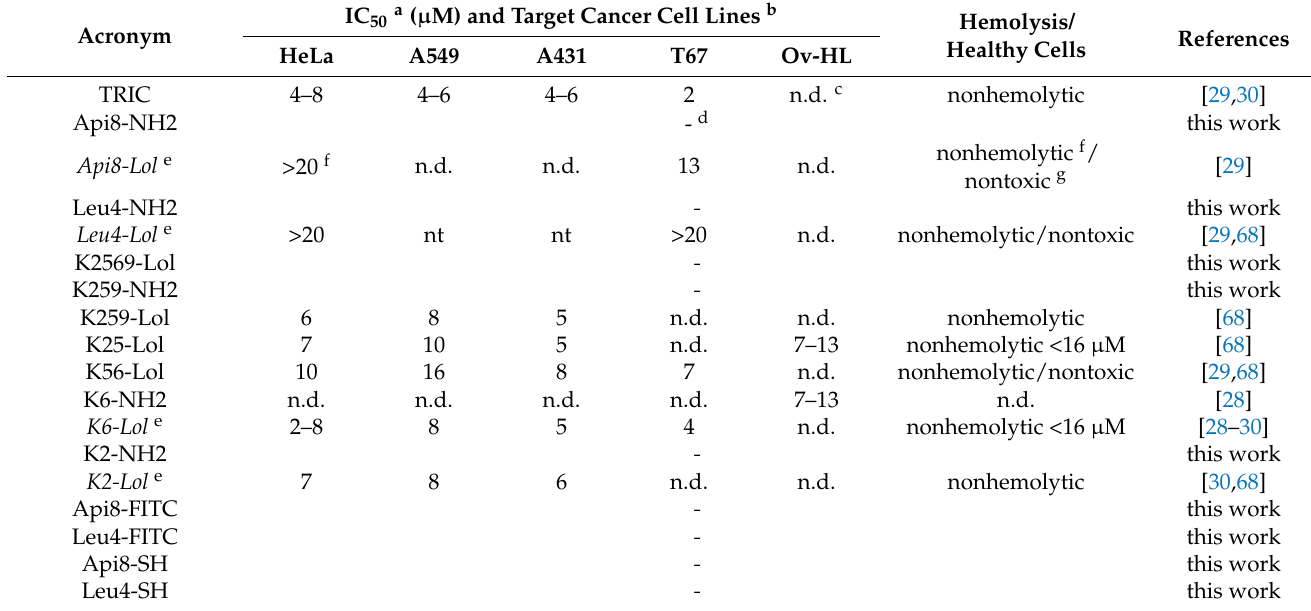
(Table 3). For convenience, peptides have been subdivided based on their C-terminal sub-